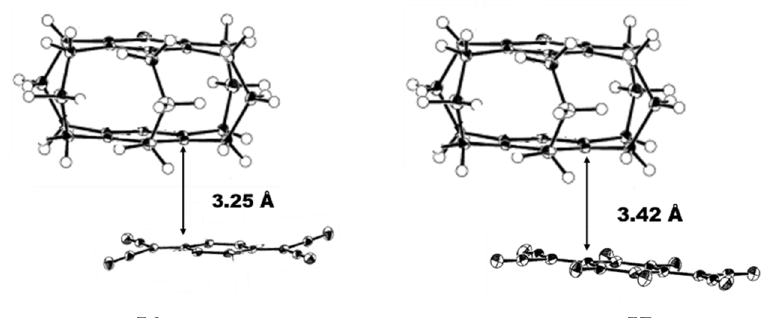
Figure 26. ORTEP drawings of complex 56 and 57 at − 180 °C (the probability of thermal ellipsoid is 50%).